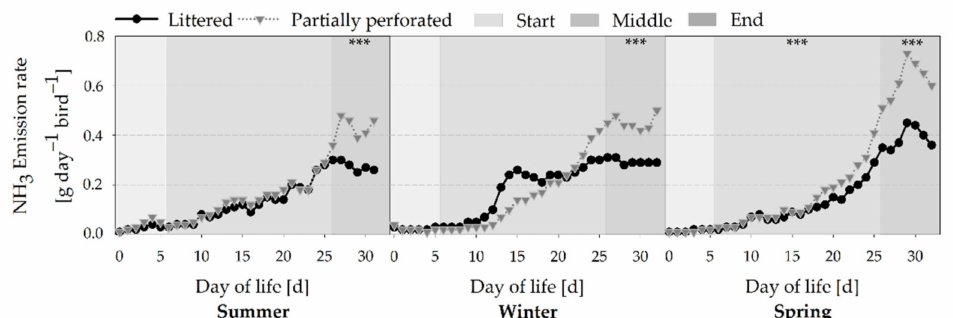
Figure 8. Average daily ammonia (NH 3 ) emission rate from broiler houses with two different floor types measured over three different fattening periods ( n = 24 values per day and barn). Significant differences between both floor types within the three different sections (start, middle, end of the fattening period) are marked by asterisks: *** p <